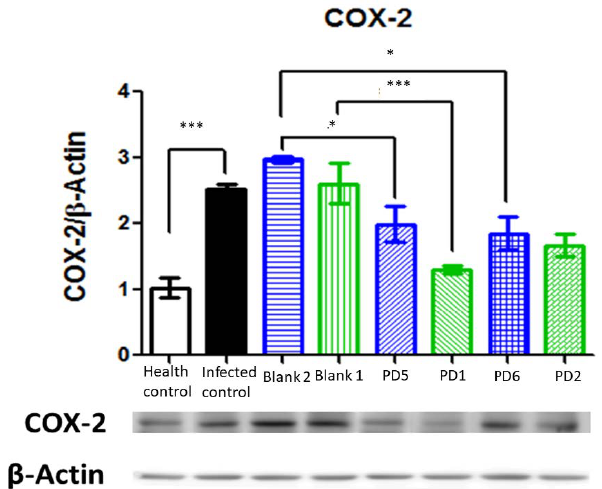
Figure 18. Cyclooxygenase (COX)-2 expression normalized by β -actine in the stomachs after different treatments and controls. Blank 1: Mucolast ® , Blank 2: PBS. PD1: Amox 89.4 mg/kg/day, Clar 44.7 mg/kg/day in Mucolast ® . PD2: Amox 44.7 mg/kg/day, Clar 22.35 mg/kg/day in Mucolast ® . PD5: Amox 89.4 mg/kg/day, Clar 44.7 mg/kg/day in PBS. PD6: Amox 44.7 mg/kg/day,